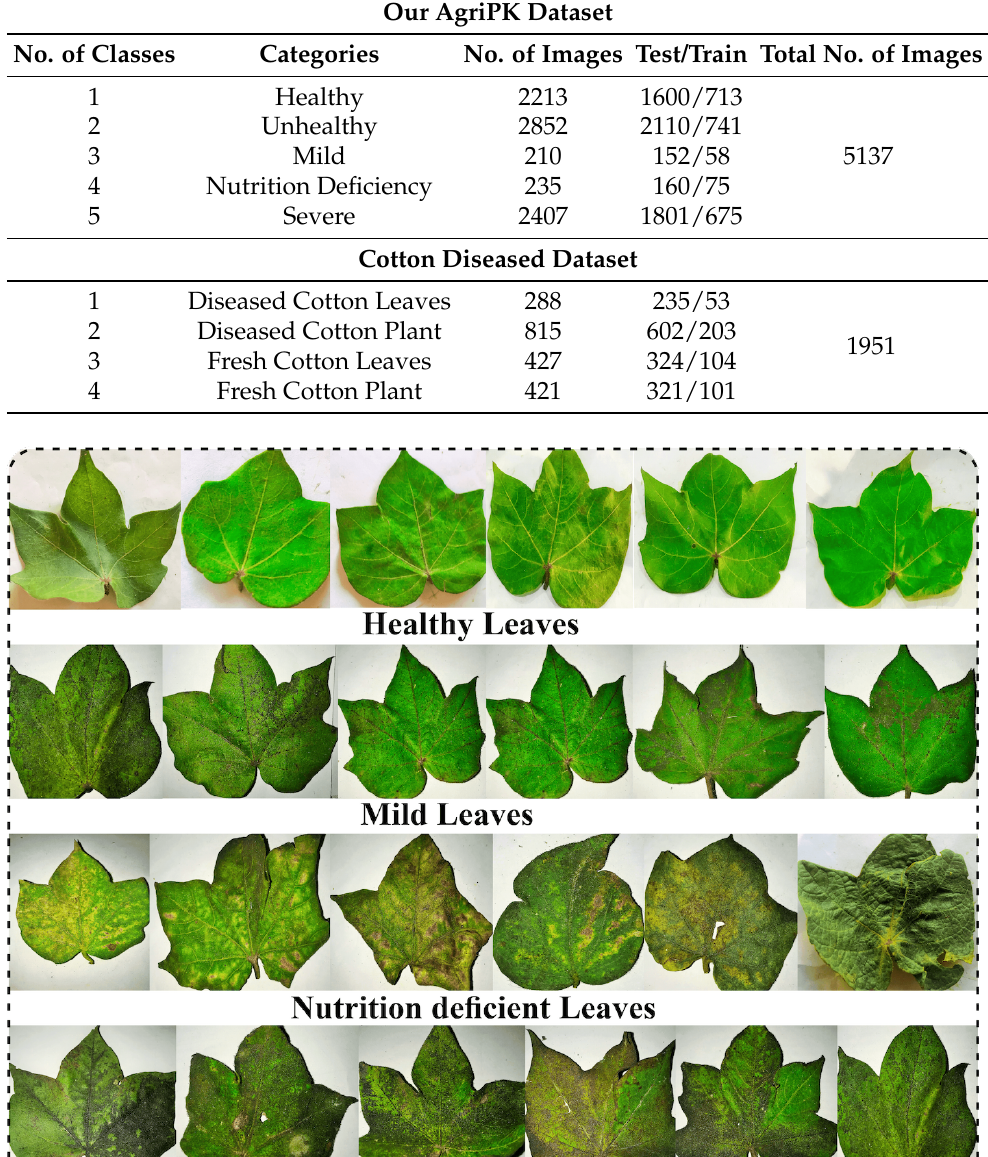
Table 1. Dataset used for this study.